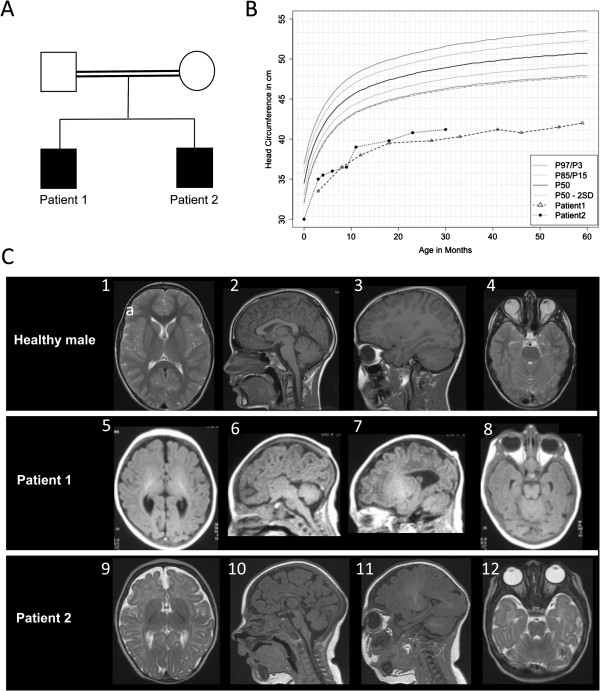
Clinical features of MCPH3 patients with novel CDK5RAP2 gene mutation. (A) Pedigree of the Italian family: the parents were third degree cousins. (B) Development of the OFC of both patients, from age 2 months to 5 years in patient 1 (triangles) and birth to 3 years 10 months in patient 2 (dots) (centiles refer to WHO Child Growth Standards) [10,11]. The OFC of patient 2 was below −3.5 SD at birth and further decreased to about −6.4 SD by the age of 3 years and 10 months. (C) T1/2-weighted magnetic resonance images (MRI) of patient 1 at age 2,5 months (5–8) and patient 2 at 3 months (9–12) compared to those of a healthy 3-year old boy. The reduced size of the brain with extra-axial spaces (5, 7, 9–11), sloping forehead (6, 7, 11), simplified gyral pattern frontally with shallow, wide sulci (5, 7, 9) and corpus callosum agenesis (6) and hypogenesis (10) are apparent.